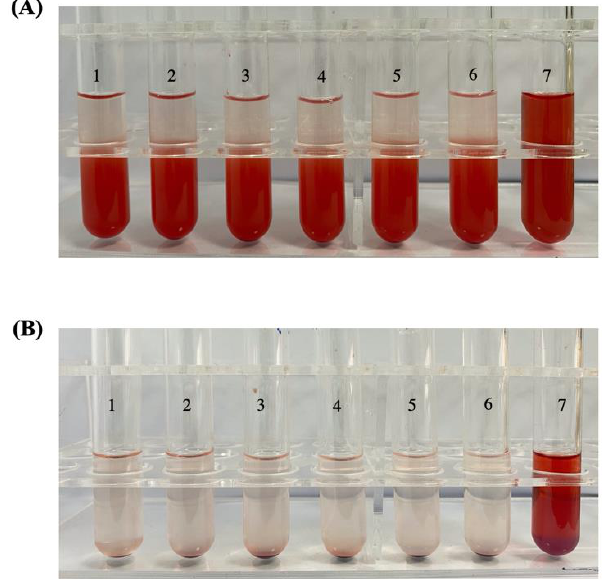
Figure 5. Hemolysis result of RBCs treated with RPTR-701Ns for; ( A ) 3 h and ( B ) 24